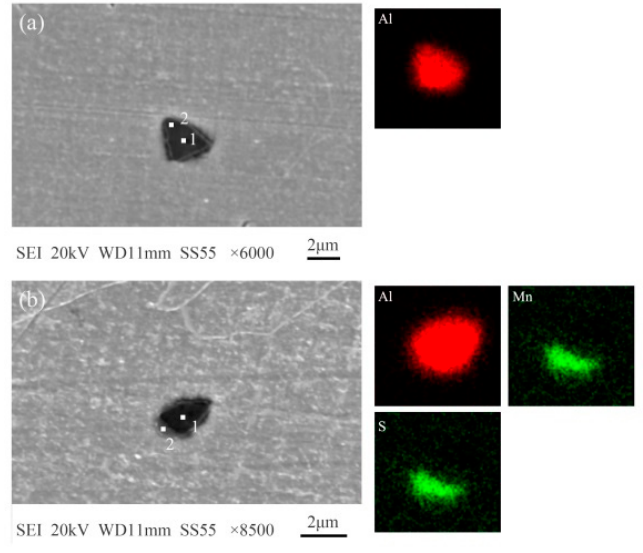
Figure 6. The SEM micrographs and EDS mapping images for typical oxides in the EAM-treated sample after etching. ( a ) typical oxide 1. ( b ) typical oxide 2. Metals 2019 , 9 , x FOR PEER REVIEW Table 3. EDS point analysis of oxides for the EAM-treated sample after etching shown in Figure 6 (mass percentage).